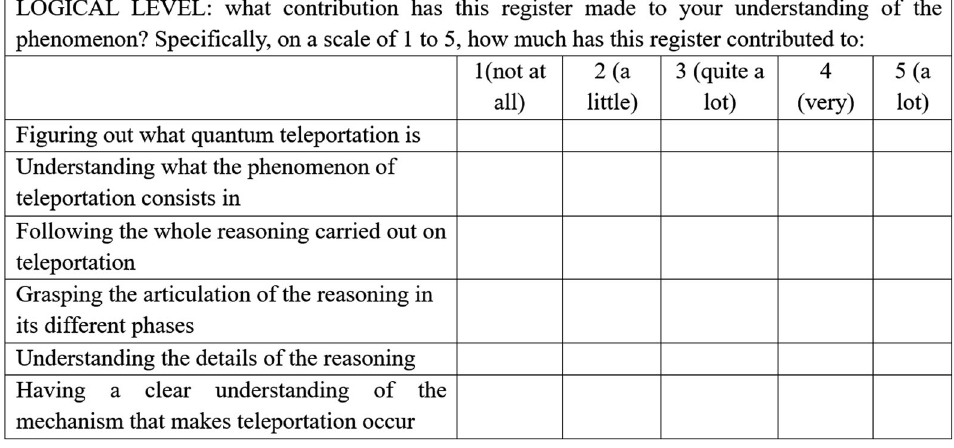
FIG. 29. About the logical level.